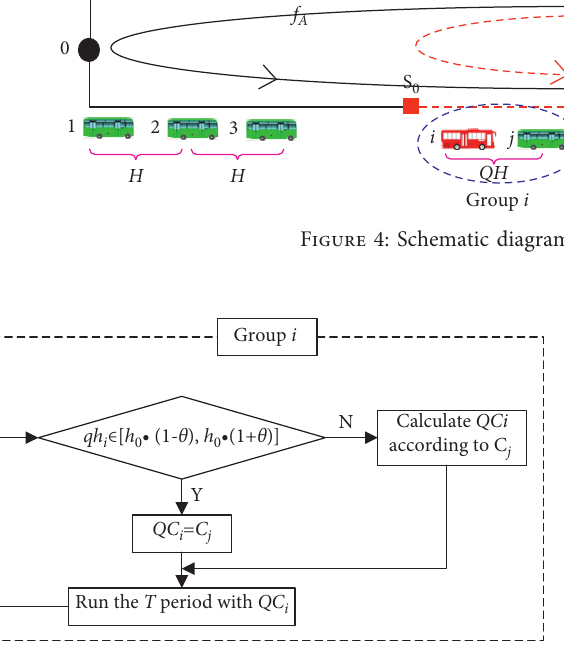
Figure 5: Control flow of the short-turning buses group.